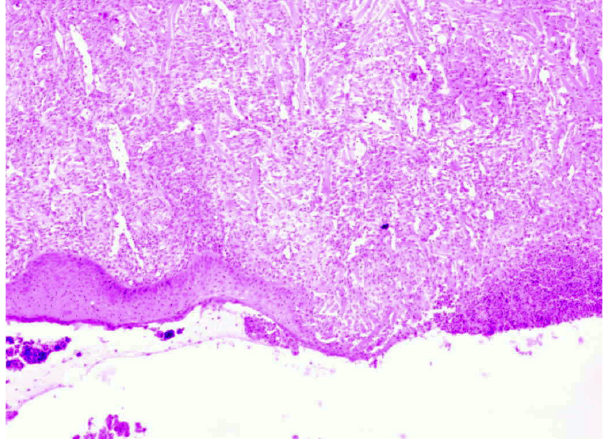
Figure 7. Day 21, D1-1% Sepropol, the entire defect covered with regenerated epidermis, defect filled with granulation with predominant collagen fibers (enlargement 150×,